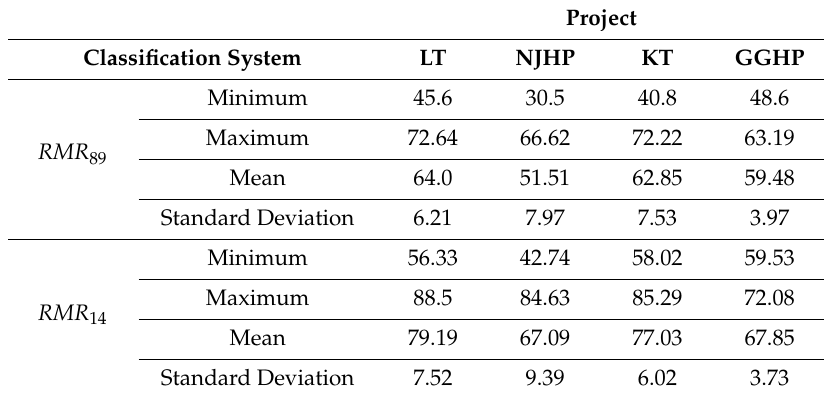
Table 2. Summary of rock-mass rating values of RMR 89 and RMR 14 for the 542 tunnel sections obtained through rock-mass characterization approach.